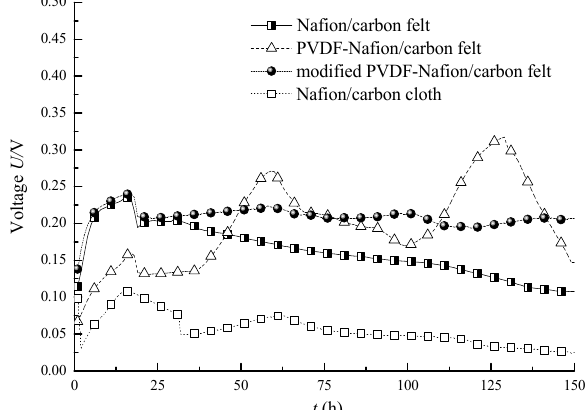
Figure 2. Output voltage curves of MFCs under different conditions.